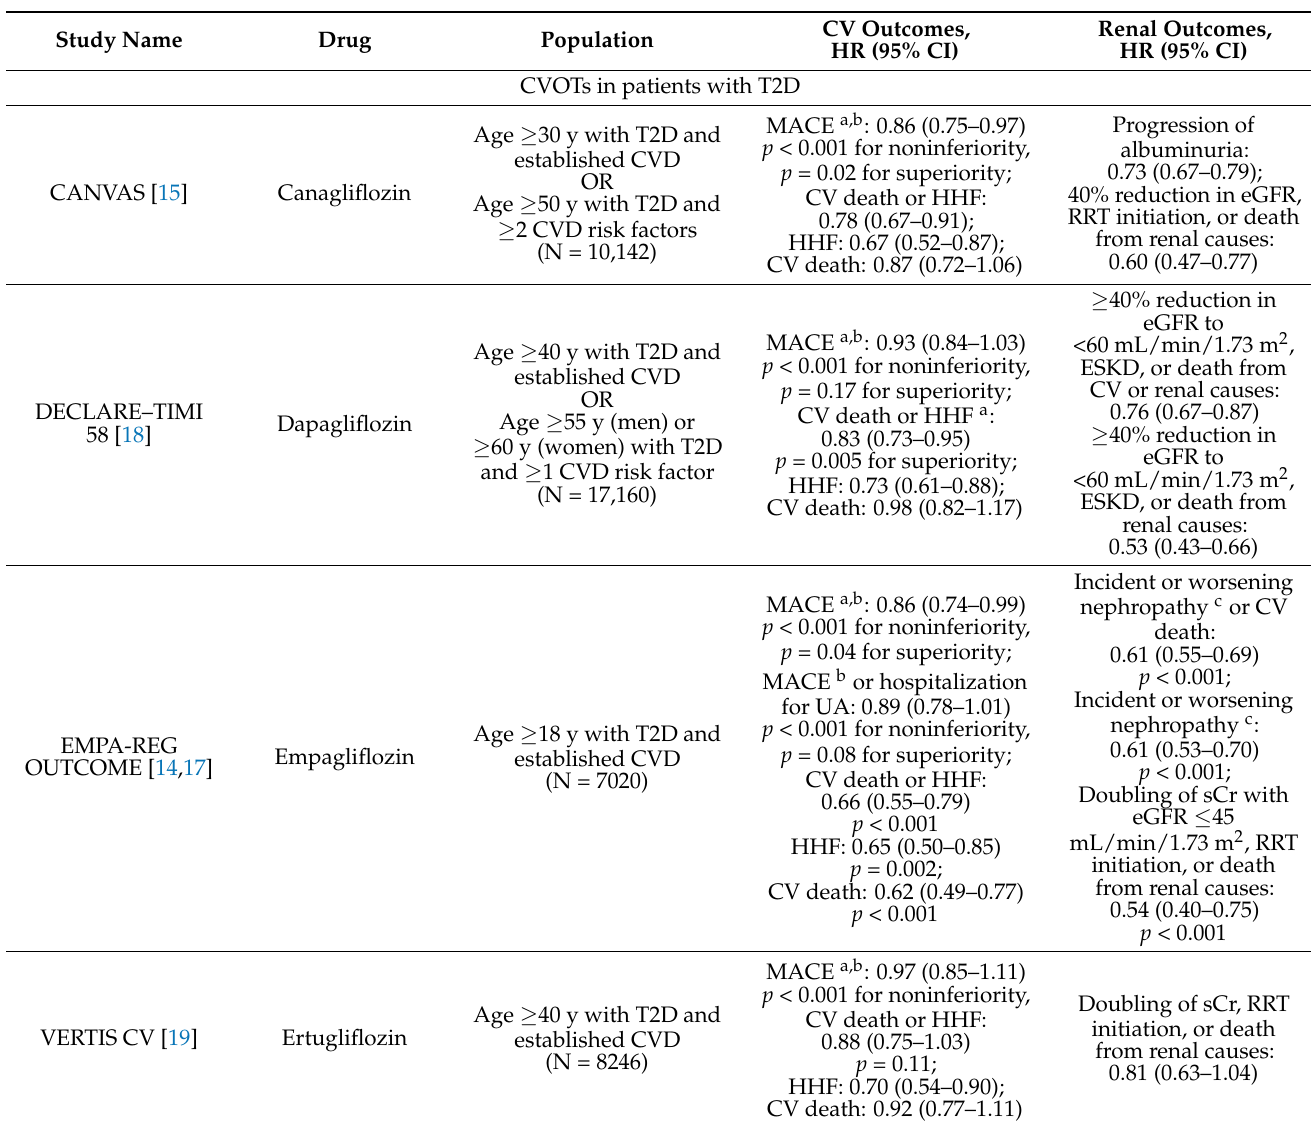
Table 1. The effect of SGLT2i therapy on cardiovascular and renal outcomes in clinical